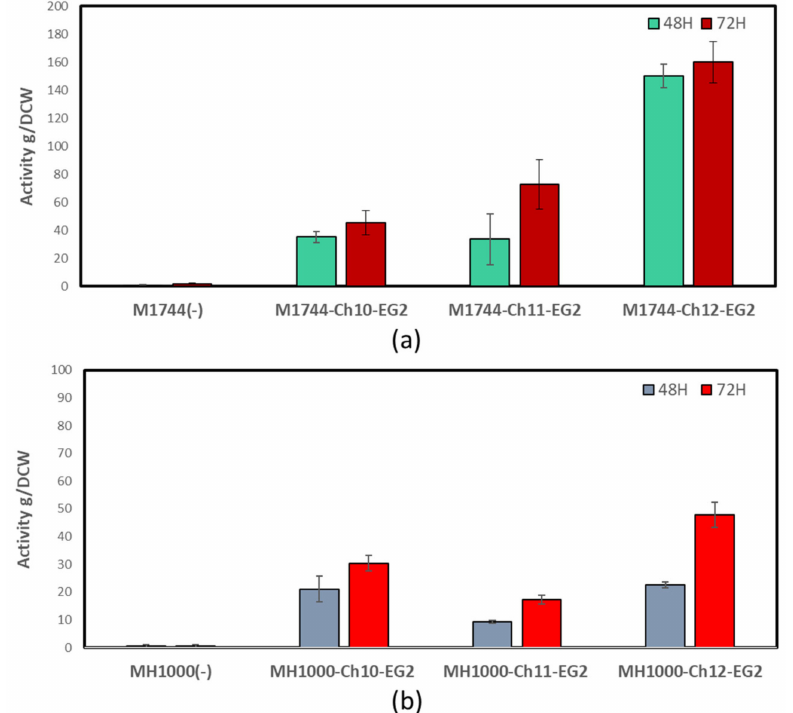
Figure 2. Endoglucanase activity profiles of recombinant yeast strains after 48 and 72 h cultivation. ( a ) The activity of EG2 producing haploid strains on CMC. ( b ) The activity of EG2 producing diploid strains on CMC. Values obtained were normalized with the dry cell weight of each specific yeast strain. The M1744 and MH1000 parental strains were used as negative control reference strains. The values given are the mean values of enzyme assays conducted in triplicate. Error bars indicate the standard deviation from the mean value for each